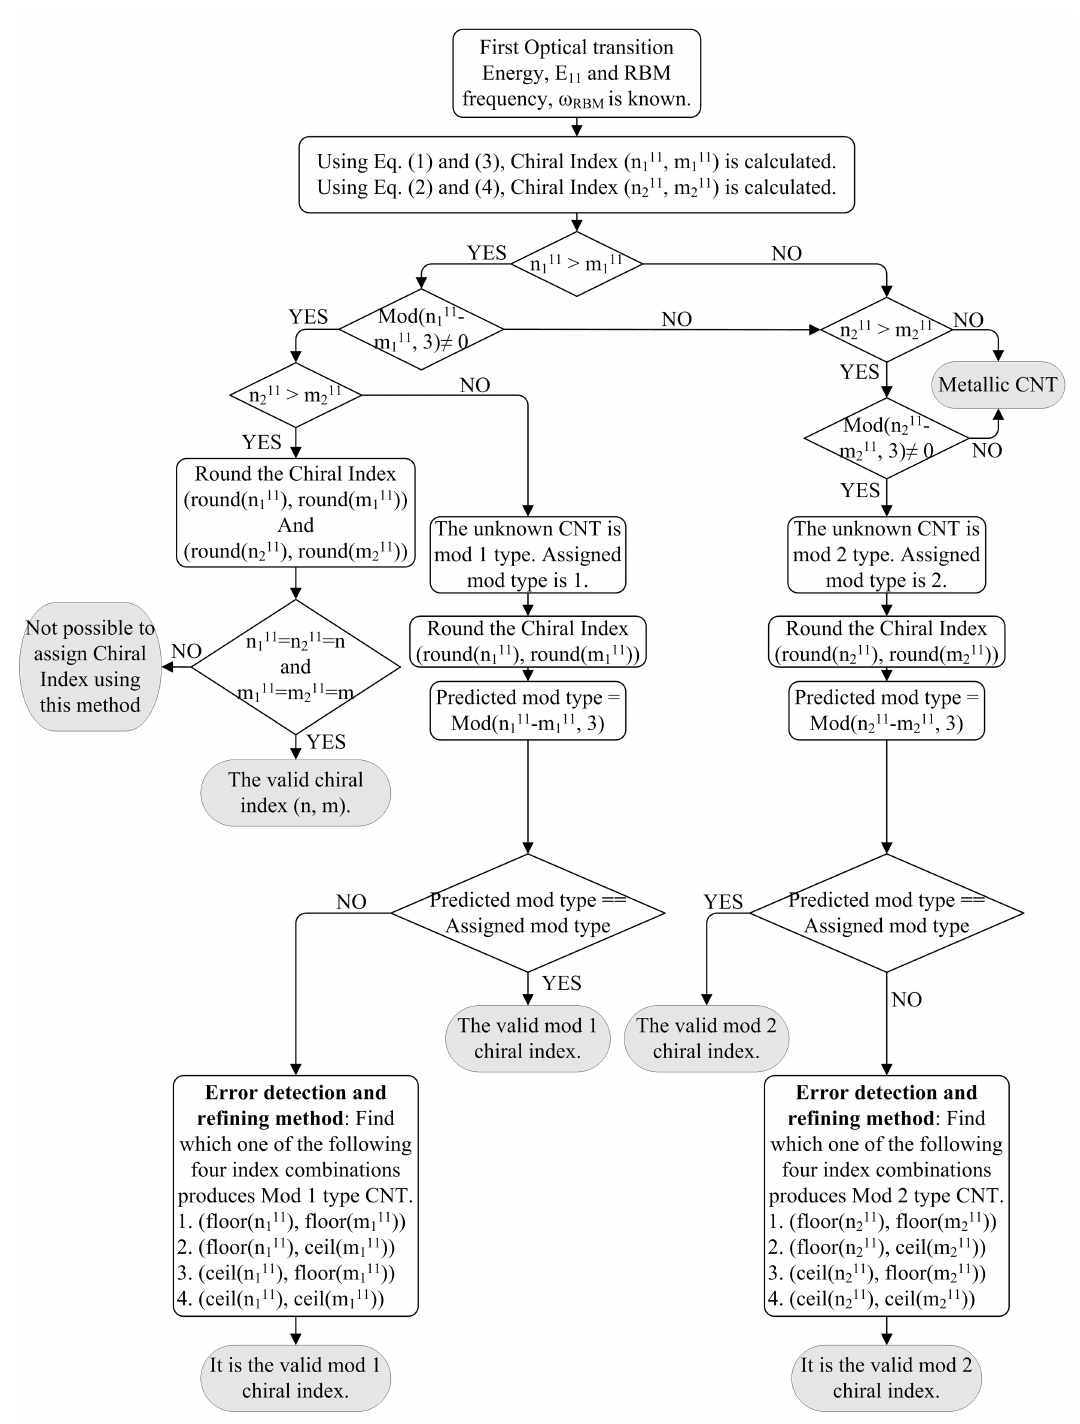
Figure 3. A flow chart of the algorithm to determine the chiral index ( n; m ) of unknown SWCNT from RRS experiment (RBM frequency, ! energy, E . Same algorithm is used to determine chiral index for second optical transition 11 energy, E 22